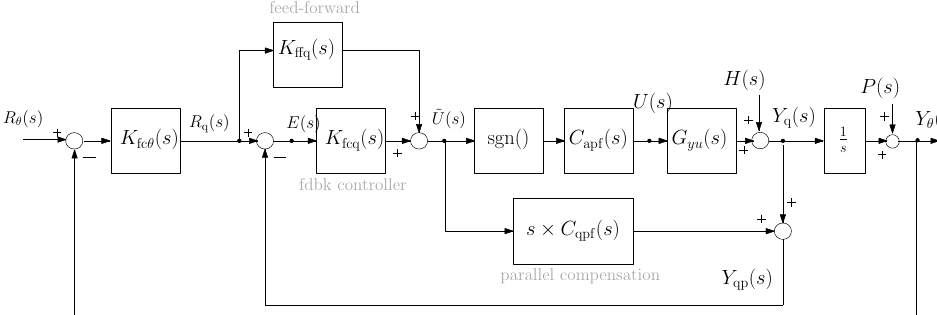
Figure 8. The PFCD architecture control feedback setup (adapted from [22]), for